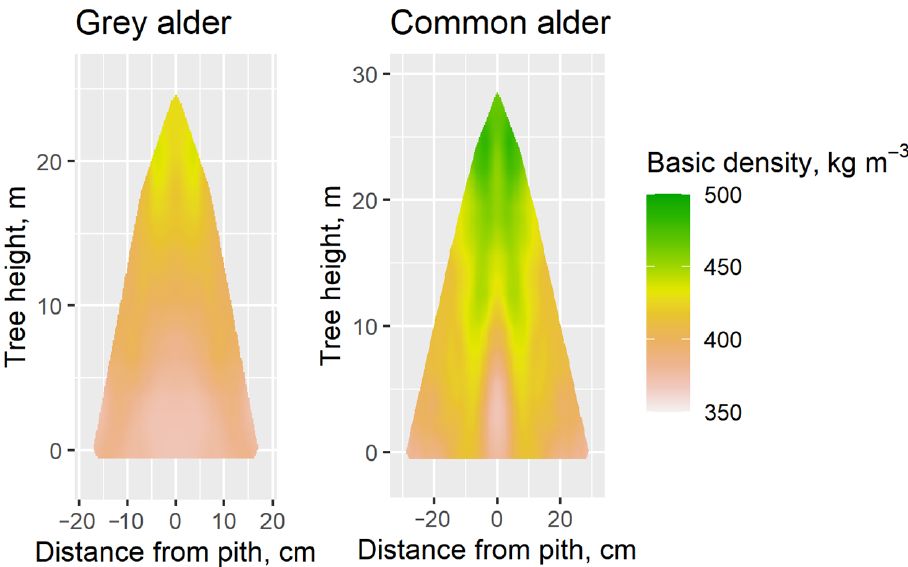
Figure 4. Variation in the basic density within the stem wood of common alder and gray alder. The 0 m point corresponds to stump (felling) height. The BD of aboveground components of both species displayed a stronger correlation with tree age, DBH, and stem length (H) than that of the belowground components (Table 3). The individual tree attributes of gray alder were positively correlated with the BD of stem wood and the total stem; however, the relationship was not strong ( ρ = 0.181–0.31). The correlation between tree attributes, bark, and branch BD was substantially stronger ( ρ ranging from 0.365 to 0.585). Relationships between tree attributes, stem wood, and total stem BD were stronger for common alder than for gray alder ( ρ = 0.506–0.669). For common alder, the data revealed a strong positive correlation between branch BD and tree attributes ( ρ = 0.559–0.698). Nevertheless, a strong negative relationship was found between tree attributes and bark BD ( ρ = − 0.794–0.712). Age, DBH, and H showed a positive relationship with average coarse root BD for common alder; however, no correlation between BD of belowground components with tree attributes was found for gray alder. Table 3. Correlation between individual tree attributes and the average basic density of tree compo- nents. The upper diagonal part (in bold) contains correlation coefficient estimates (Spearman’s ρ ). The lower diagonal part (in italics) contains the corresponding p -values.